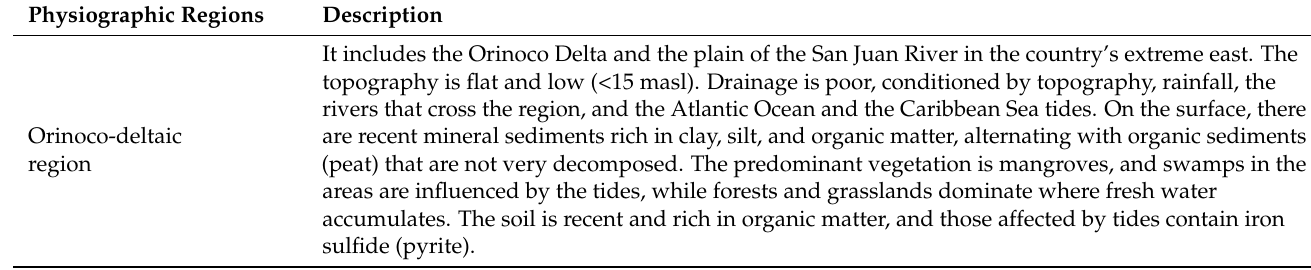
Table A2. Physiographic regions of the mountain range north of the Orinoco River according to